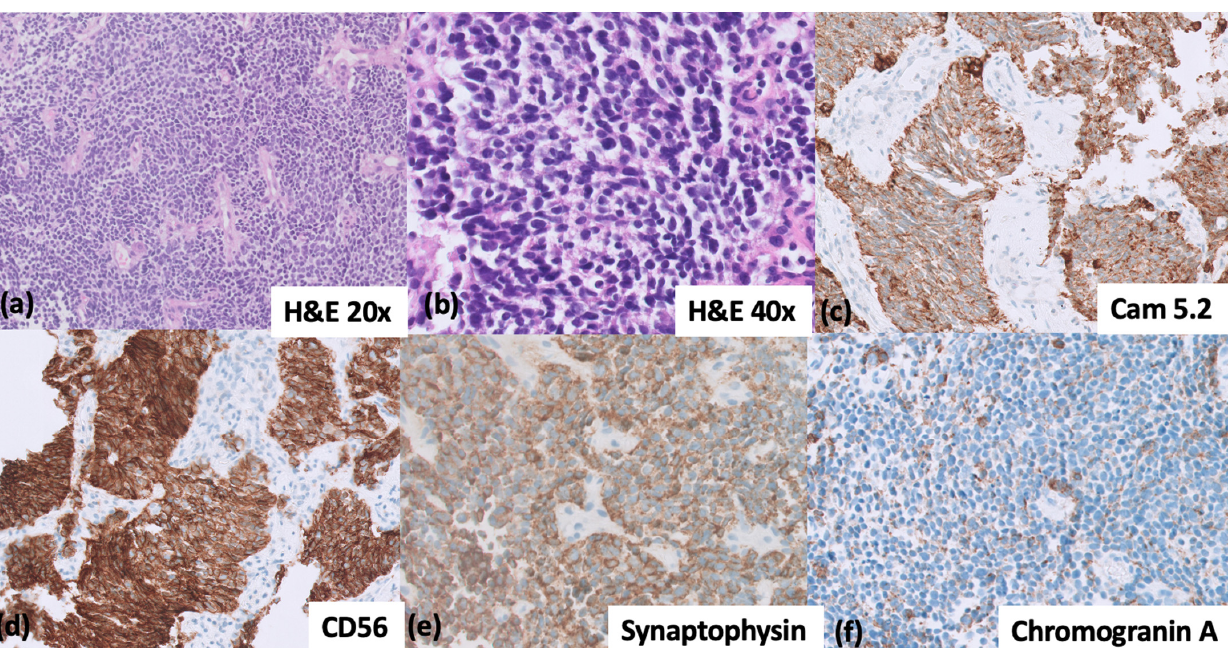
Figure 1. ( a – f ) Immunohistochemical patterns for the diagnosis of small-cell lung cancer. ( a , b ) H&E image of SCLC at 20× and 40× magnification, respectively. ( c ) CAM 5.2 with a dot-like pattern of cytoplasmic positivity; ( d ) CD56, strong positivity; ( e ) Synaptophysin, diffusely positive; ( f ) Chromogranin A, dot-like positivity in cytoplasm, pathognomonic of SCLC. ( b – f ) taken at 40× magnification.